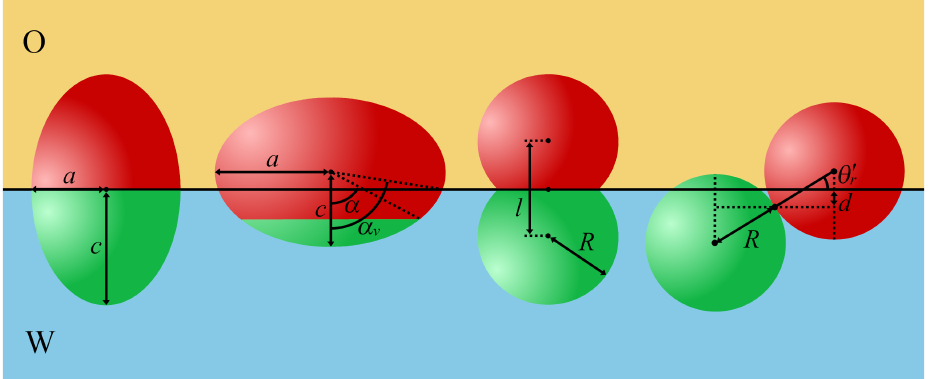
Figure 4. Examples of nonspherical Janus particles at a planar fluid/fluid interface (from left): a symmetrical ellipsoid, an asymmetrical ellipsoid, a symmetrical Janus dumbbell, and a symmetrical Janus dimer. The polar (apolar) regions of Janus particles are green (red). The aspect ratios are defined as follows: AR e = c / a for the ellipsoids and AR d = ( 2 R + l ) /2 R for the dumbbells. The angle θ (cid:48) r characterizes the orientation of the particle with respect to the